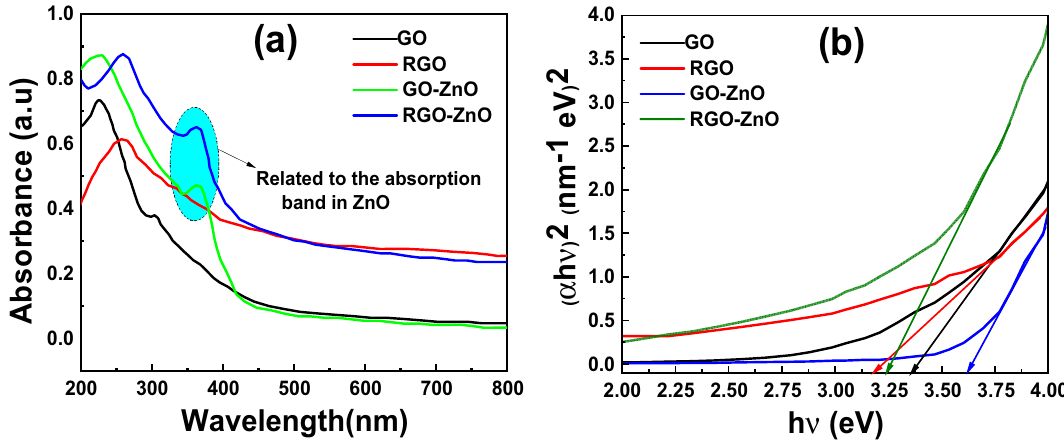
Figure 4. ( a ) Absorbance spectra of GO, RGO, GO-ZnO, and RGO-ZnO nanocomposite and ( b ) band gap determination according to absorption measurements of GO, RGO, GO-ZnO, and